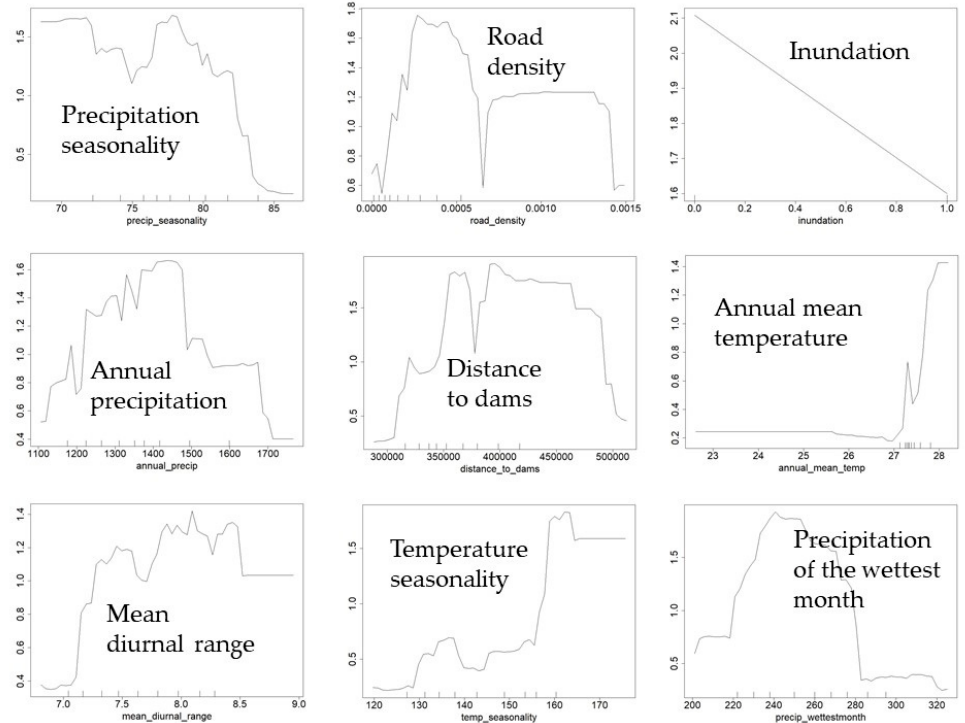
Figure A6. Top nine predictor variables for the Tonle Sap model make up 50% of the variable contribution. Note the small vertical lines on the x axis (rug) that indicate where the majority of the data points are located.